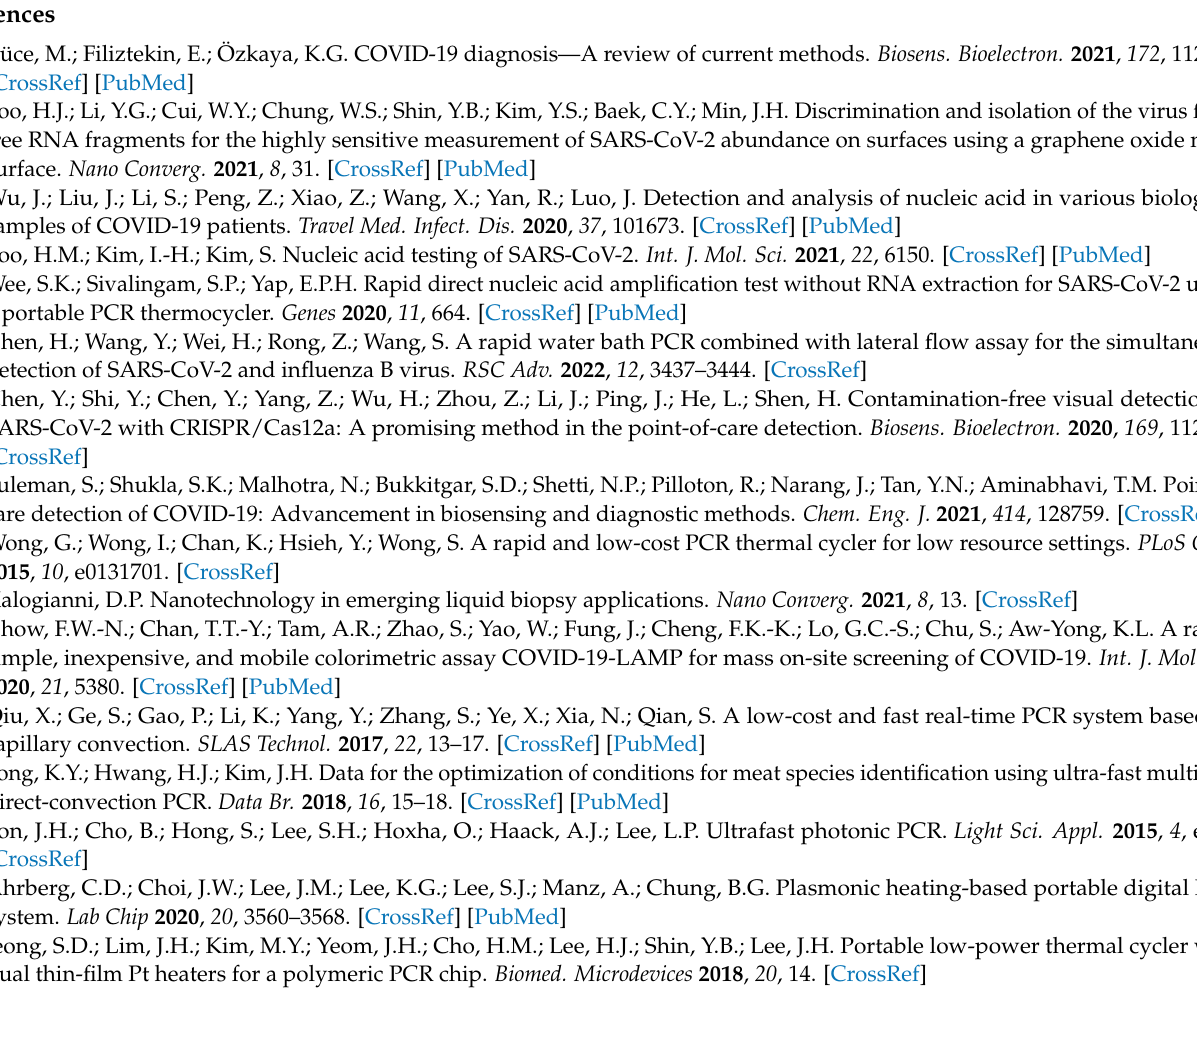
Table S2: Comparison between the Ag/CF-film-based thermal cycler and commercially available thermal